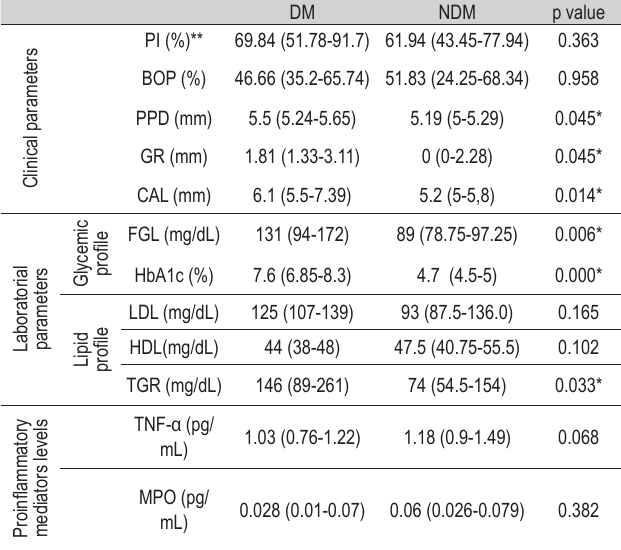
Table 2 - Summary of clinical and laboratorial parameters and proinflammatory mediators levels for DM and NDM groups. Data were expressed in medians